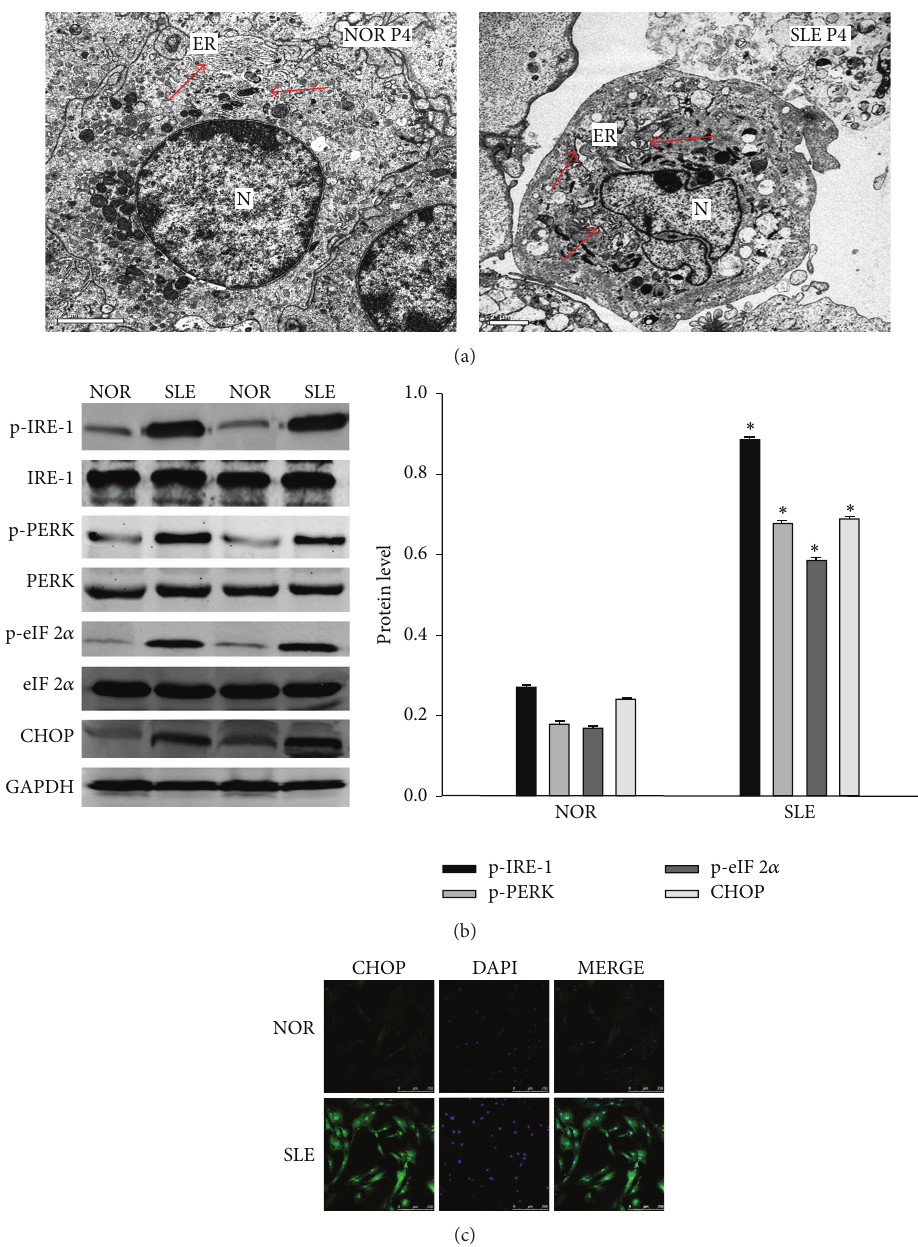
Figure 2: ERS was involved with BM-MSCs from SLE patients. (a) ER ultrastructural changes in the BM-MSCs from SLE patients and normal controls. The BM-MSCs were processed and examined under a transmission electron microscope. Compared with the control, there was an extensive increase in the size of the ER in BM-MSCs from SLE patients, in which arrows indicate protein aggregates within ER lumen. ER, endoplasmic reticulum; N, nucleus. Arrow indicates the normal ER or the dilatation of ER. (b) Upregulated expression of genes involved in ERS in BM-MSCs of SLE patients and normal controls. The levels of p-IRE-1, p-PERK, p-eIF 2 𝛼 and CHOP were analyzed by using Western Blot analysis. Total IRE-1, PERK, eIF 2 𝛼 and GAPDH were used as control for protein loading. (c) Immunofluorescence analysis of CHOP expression in the control group or SLE group. (Bar represents mean ± SD, ∗ 𝑃 < 0.05 compared with the normal